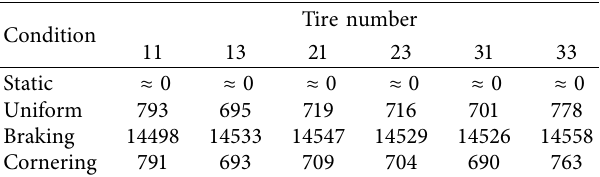
Table 8: Longitudinal tire load under different running conditions (N).